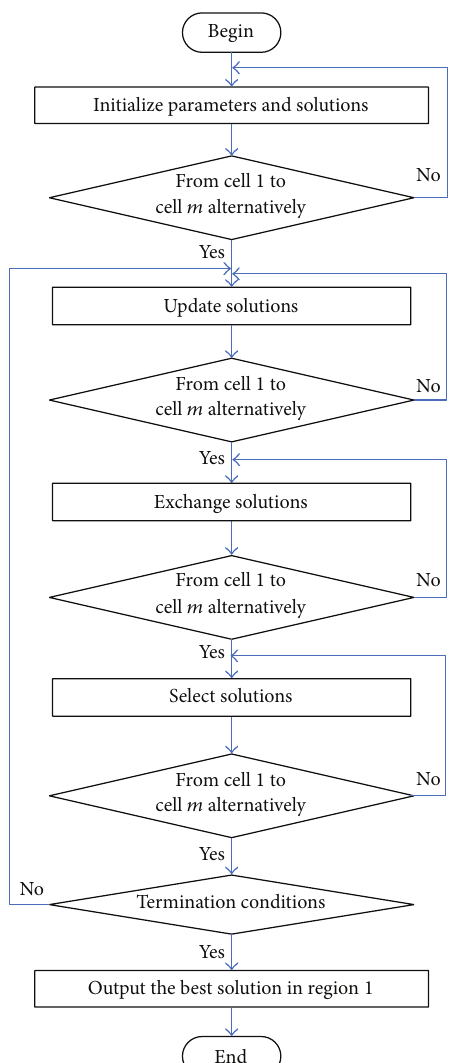
Figure 1: The CPU implementation procedure of membrane algo-